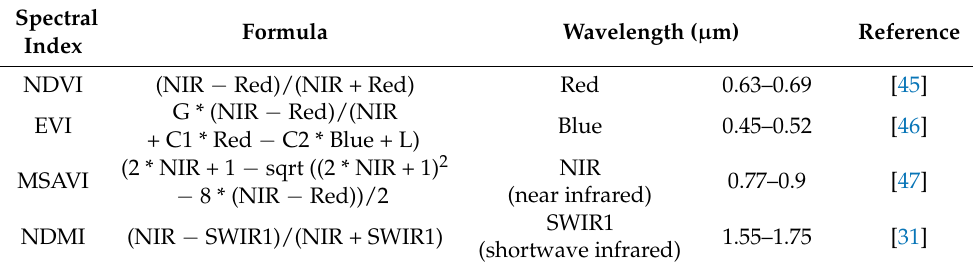
Table 1. Spectral indices used for time series analysis.